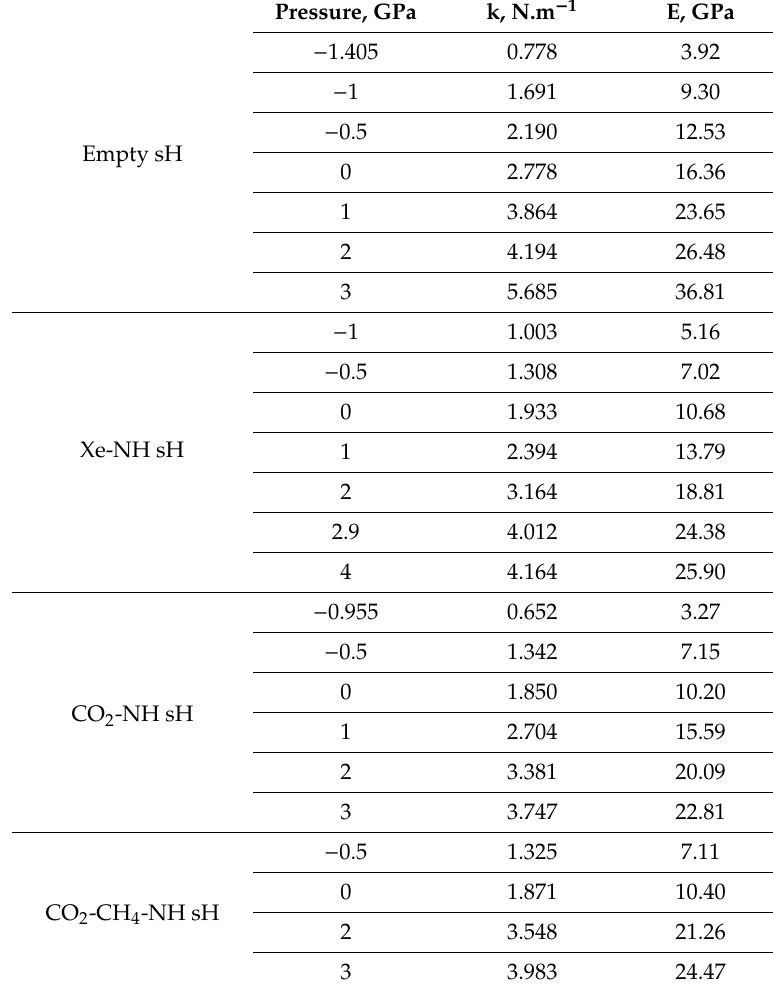
Table 6. Pressure dependence of hydrogen bond force constant ( k ) and Young’s modulus ( E ) of sH gas